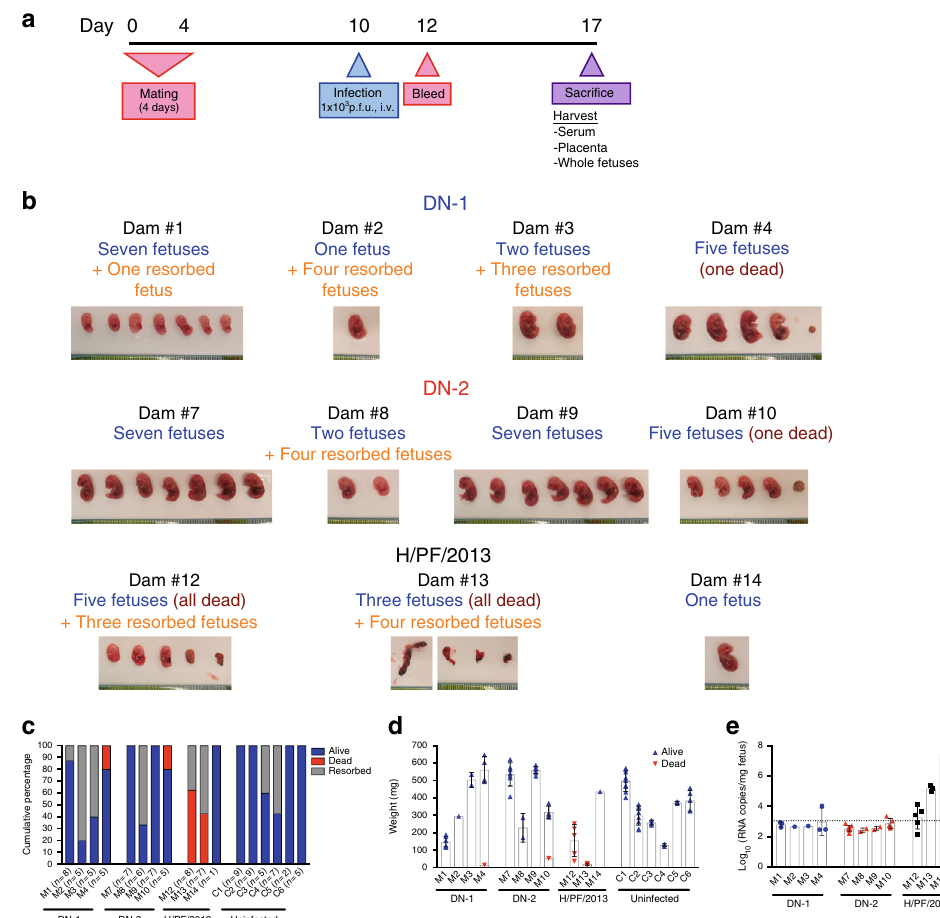
Fig. 9 Decreased vertical transmission during DN-2 infection of pregnant A129 mice. a DN-1, DN-2 and H/PF/2013 were tested in a pregnant mouse model according to the timeline shown. b – e The dams ( n = 5 for DN-1 and DN-2, n = 4 for H/PF/2013) were killed at day 7 post infection. Of these mice (infected dams numbered M1 to M14 with n = number of fetuses indicated, uninfected controls numbered C1 – C6), four each in the DN-1 and DN-2-infected dams and three in the H/PF/13-infected group were pregnant and the placenta and fetuses were also collected. b Fetuses of infected pregnant dams showing absence or presence of gross pathological changes caused by vertical ZIKV transmission. c Survival and d weight of fetuses were determined and e viral RNA quanti fi cation was performed on whole fetus homogenates using qPCR. See also Supplementary Fig. 6. Error bars represent s.d. Dotted lines on viral quanti fi cation graphs represent limit of